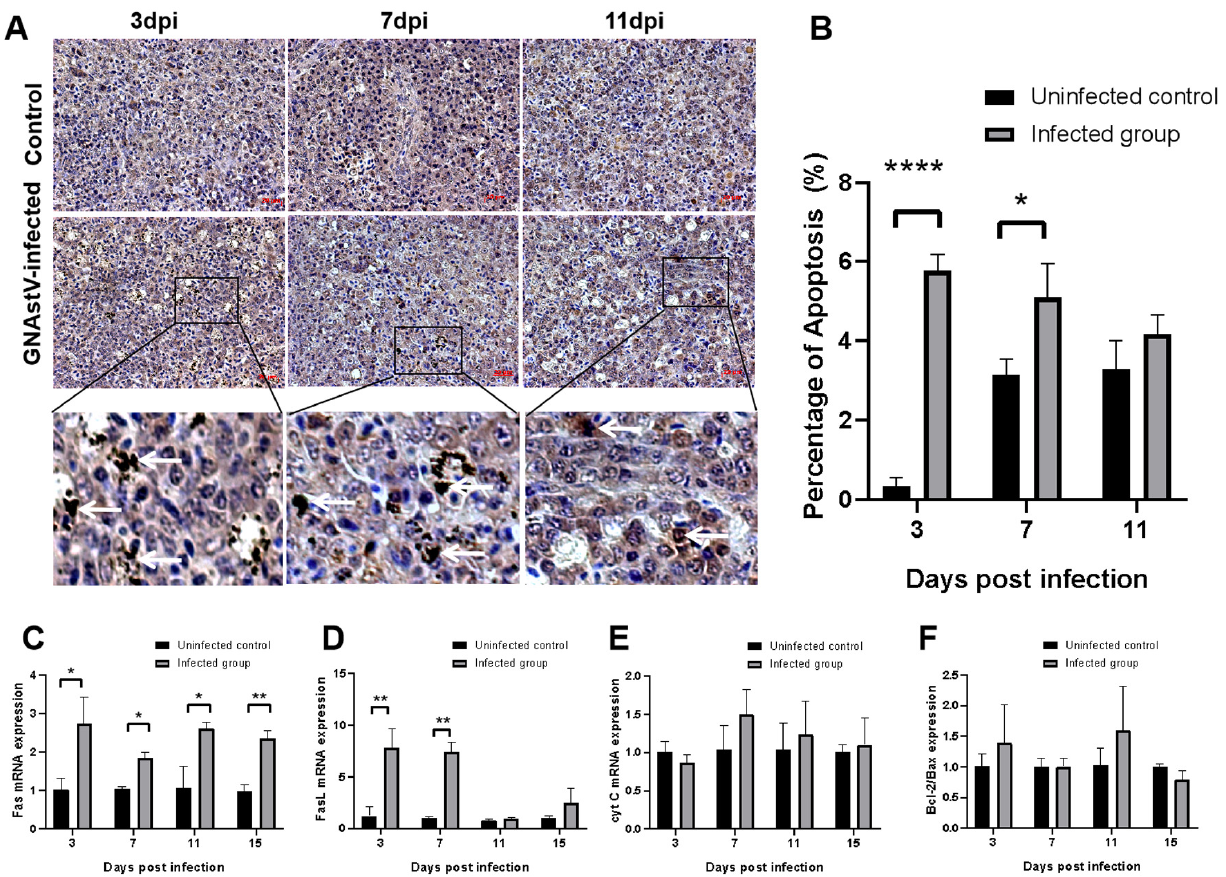
Figure 7. Effects of GNAstV infection on apoptosis of splenic cells. Paraffin-embedded sections of spleen tissue were stained by the TUNEL method ( A ). The apoptotic index was calculated as the percentage of TUNEL-positive cells in spleen cells ( B ). Changes in the mRNA levels of Fas ( C ), FasL ( D ), and cyt C ( E ), and the ratio of Bcl-2/Bax ( F ) in the spleen at 3, 7, 11, and 15 dpi in goslings infected with GNAstV were determined. White arrow: apoptosis of splenic cells. Scale bar: 20 µ m. Values are expressed as mean ± SD, n = 5. * p < 0.05; ** p < 0.01; **** p <